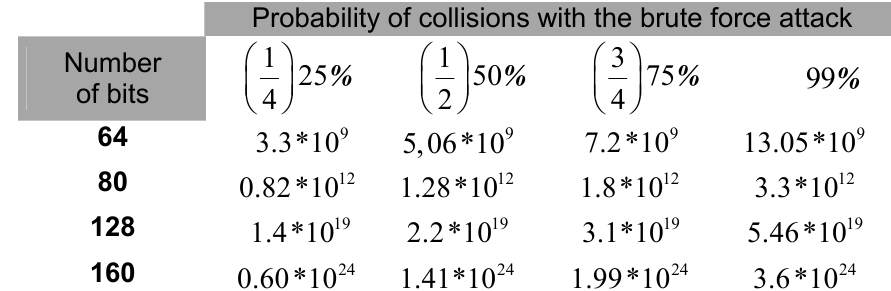
Table 2 – The results of the desired probability when passwords are 64, 80, 128 and 160 bits long Таблица 2 – Результаты предполагаемой вероятности , в случае длинных паролей 64, 80, 128 и 160 битов Табела 2 – Резултати жељене вероватноће када су лозинке дугачке 64, 80, 128 и 160 бита